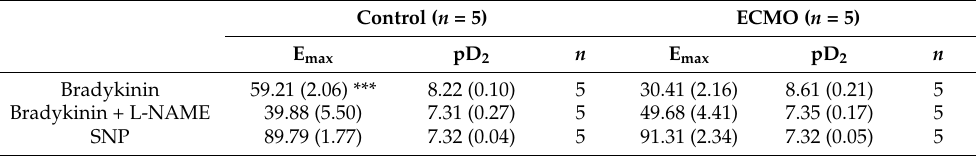
Figure 5. Relaxation of coronary arteries in response to sodium nitroprusside (SNP) was not affected by exposure to ECMO. Cumulative dose–response curves to SNP in porcine coronary artery rings in control and ECMO group. Vessels were precontracted with U46619 (1 μ M). Data points are presented as mean ± S.E.M ( n = 5 in both groups). ECMO: extracorporeal membrane oxygenation.